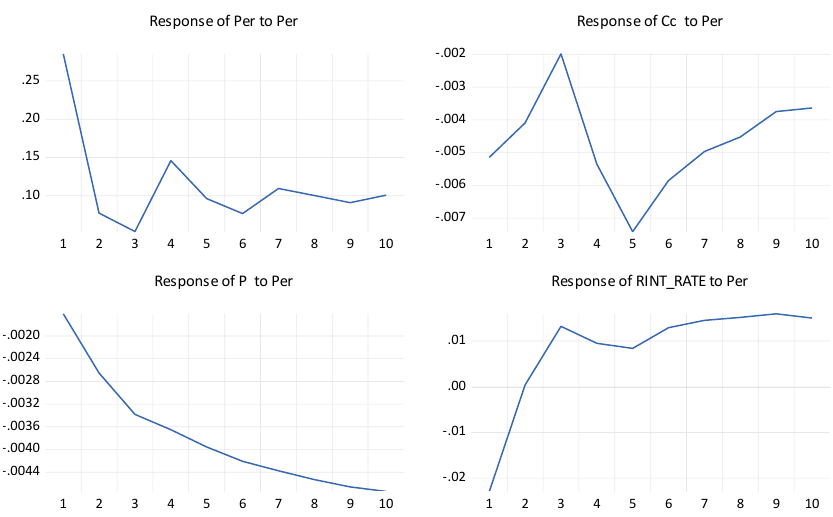
Figure 4. The response of housing permit to housing demand in Istanbul, Turkey.